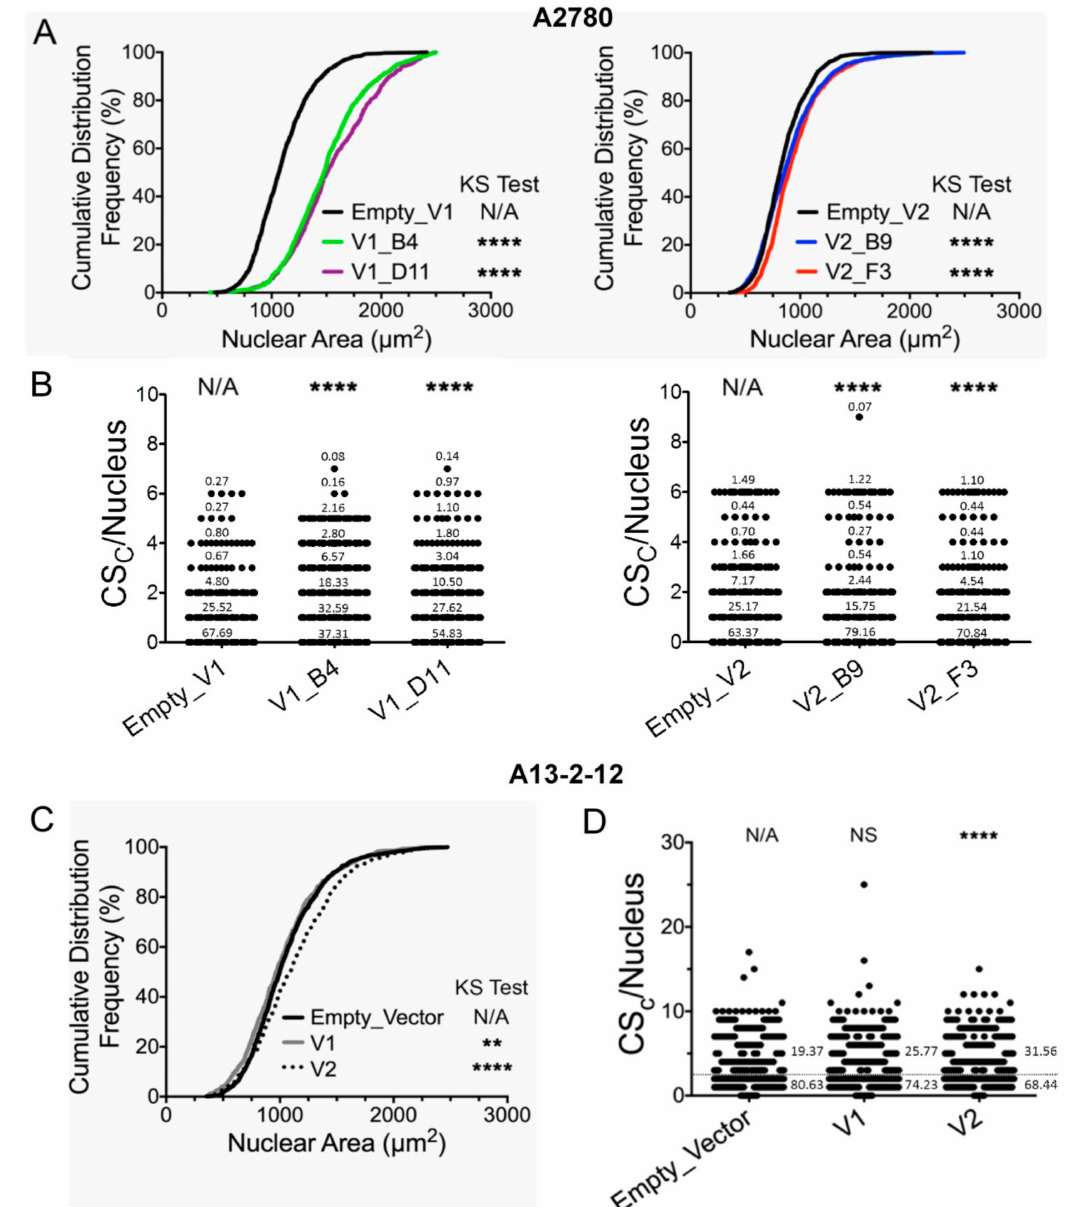
Figure 2. Overexpression of RUNX3 variants 1 and 2 induces chromosome instability (CIN) in A2780 ( A , B ) and A13-2-12 ( C , D ). ( A ) Cumulative frequency graphs showing statistically significant differences in the nuclear area distributions of two independent RUNX3 TV1 (left; V1_B4 and V1_D11) or two TV2 (right; V2_B9 and V2_F3) A2780 clones relative to empty vector controls (KS test; N/A, not applicable; **** p -value < 0.0001; n > 700 nuclei/condition). ( B ) Scatter plot showing statistically significant differences in CIN score (CS C ) values for TV1 (left) and TV2 (right) clones relative to empty vector controls (MW test; N/A, not applicable; **** p -value < 0.0001; n > 700 nuclei/condition). The percentage of cell populations exhibiting specific CS c values are shown within the plots. ( C ) Cumulative frequency graph showing statistically significant differences in nuclear area distributions following TV1 and TV2 overexpression relative to empty vector control in A13-2-12 cells (KS test; N/A, not applicable; ** p -value < 0.01; **** p -value < 0.0001; n > 800 nuclei/condition). ( D ) Scatter plot presenting the overall distribution of CS c values relative to control (MW test; N/A, not applicable; NS, not significant ( p -value > 0.05]; **** p -value < 0.0001; n > 800 nuclei/condition). The percentage of cell populations exhibiting specific range of CS c values (CS c ≤ 2 or > 2) are shown within the